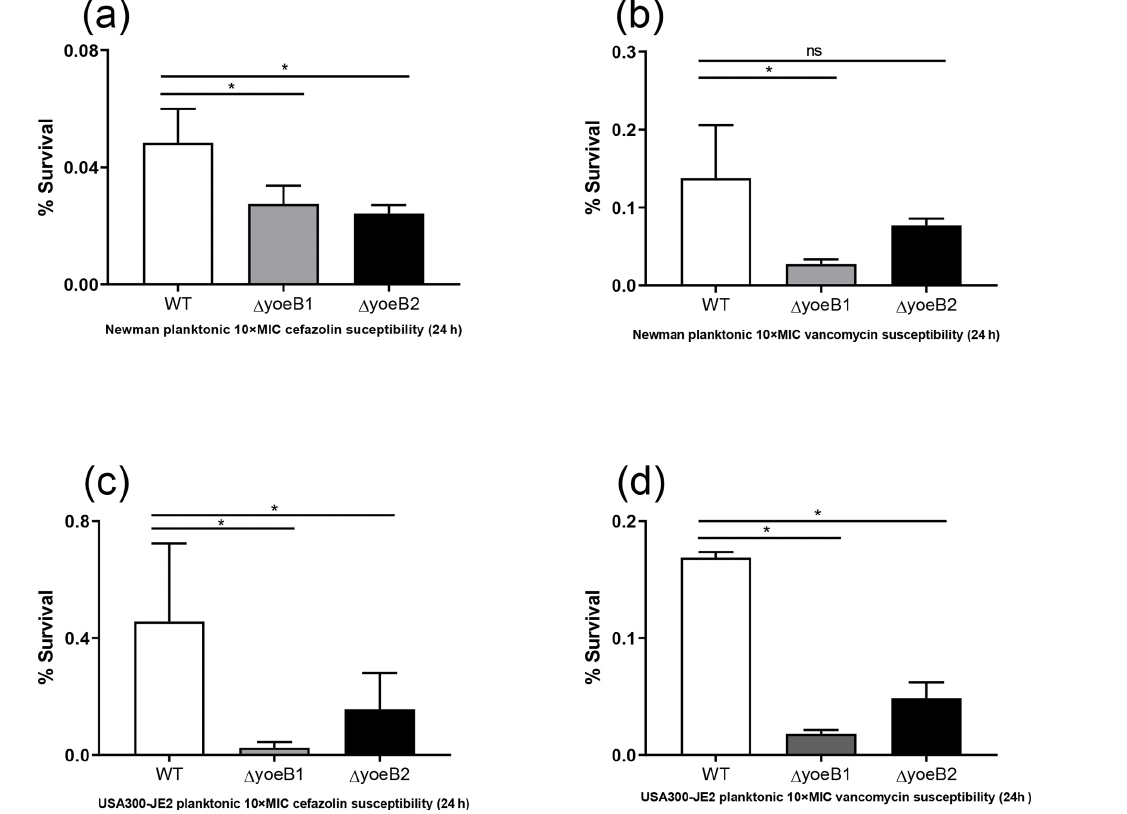
Figure 4. Loss of yoeB1 and yoeB2 increases planktonic antibiotic susceptibility. With the exception of the yoeB2 mutant, reduction of planktonic bacterial survival in yoeB mutants was observed in the Newman strain background for both (a) 10X MIC cefazolin and (b) 10X MIC vancomycin. Similar results were observed for USA300-JE2, with more notable differences observed in yoeB mutants in comparison to WT for both (c) cefazolin and (d) vancomycin (ns: not significant, * p < 0 . 05).